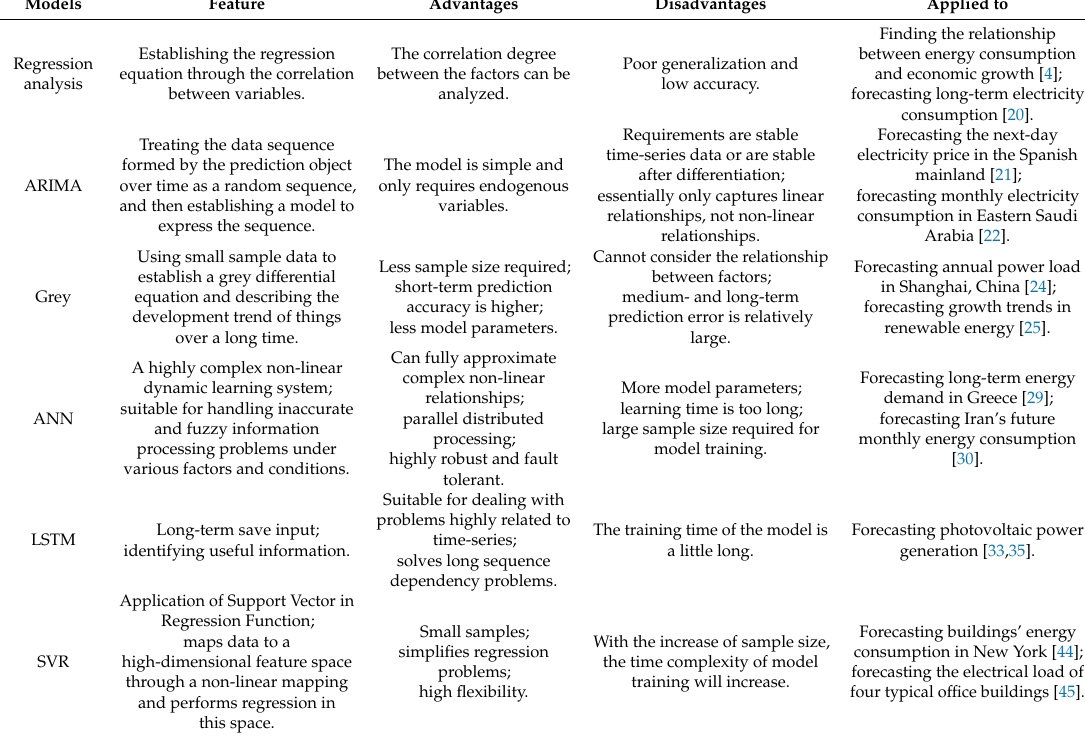
Table 1. Summary of several models commonly used for energy